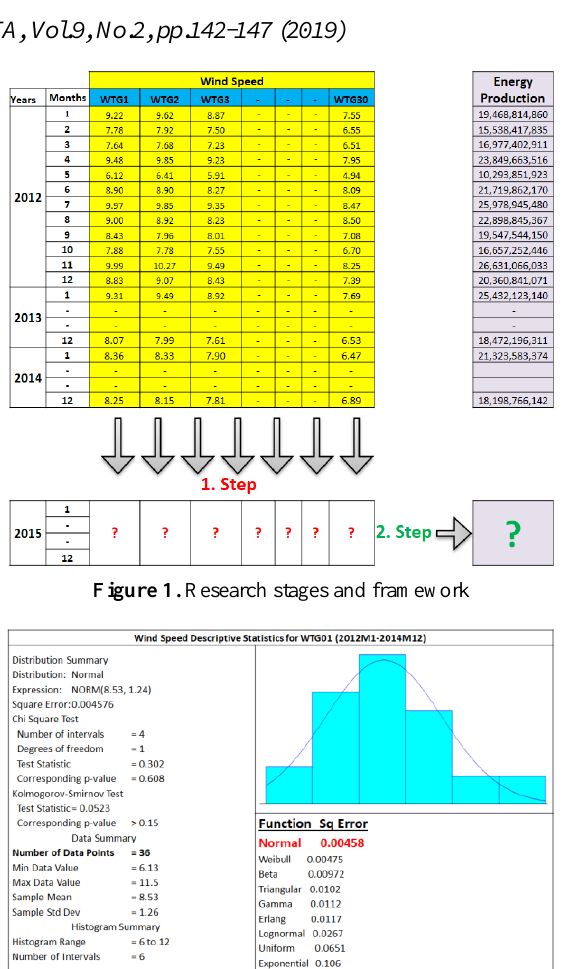
Figure 2. Arena input analyzer results of WTG1 coded